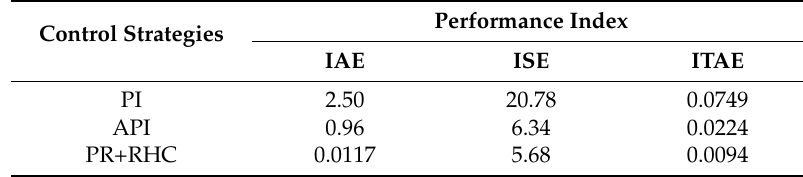
Table 4. Performance evaluation of designed control strategies for I q . Control